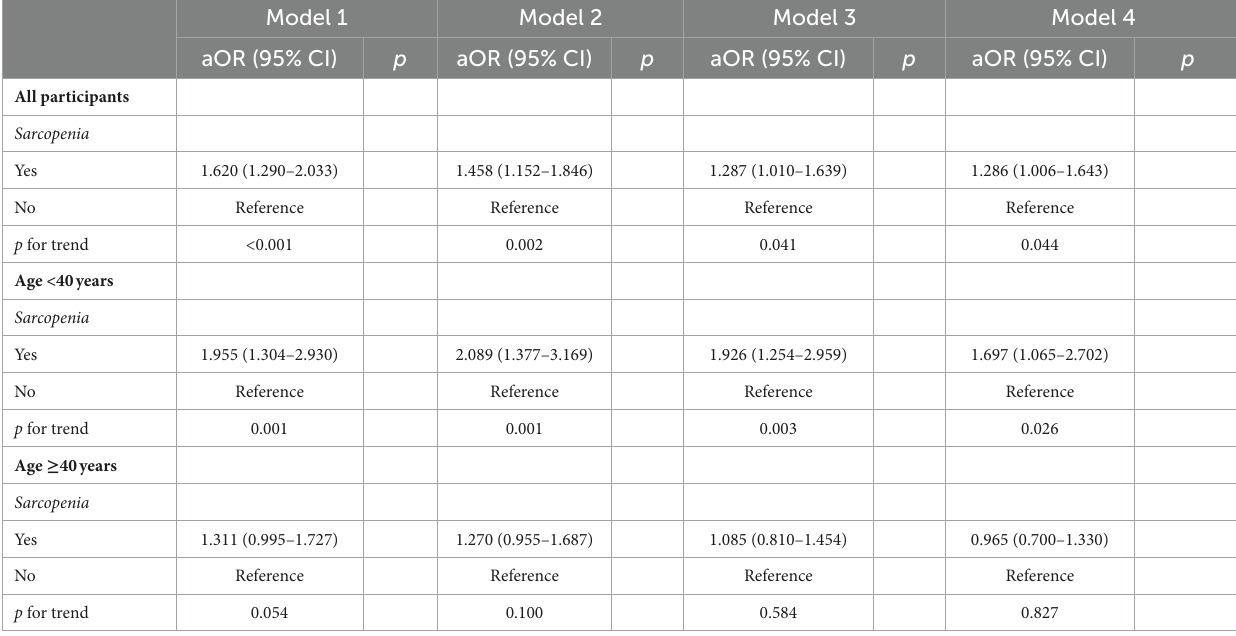
TABLE 2 Logistic regression analyzed the relationship between sarcopenia and the presence of kidney